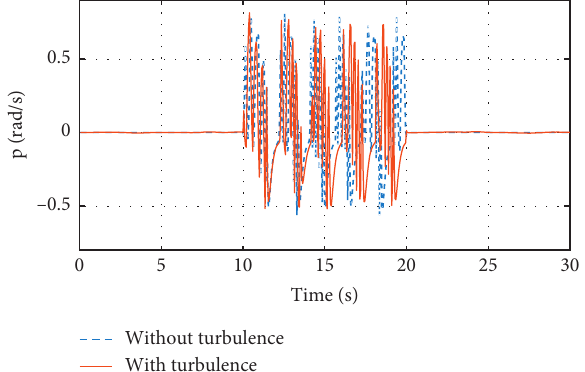
Figure 13: The difference of rolling angle rate with the time.